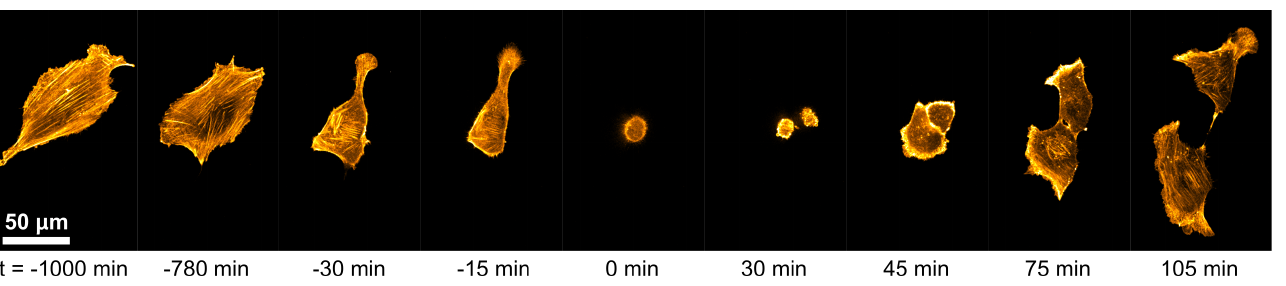
Figure 1. Proliferation dynamic of a single myocyte. Shown is an actin-tagged C2C12 muscle cell on glass that undergoes proliferation at about t = 0 min. The two daughter cells increase their size and eventually migrate independently ( t ≥ 30 min).